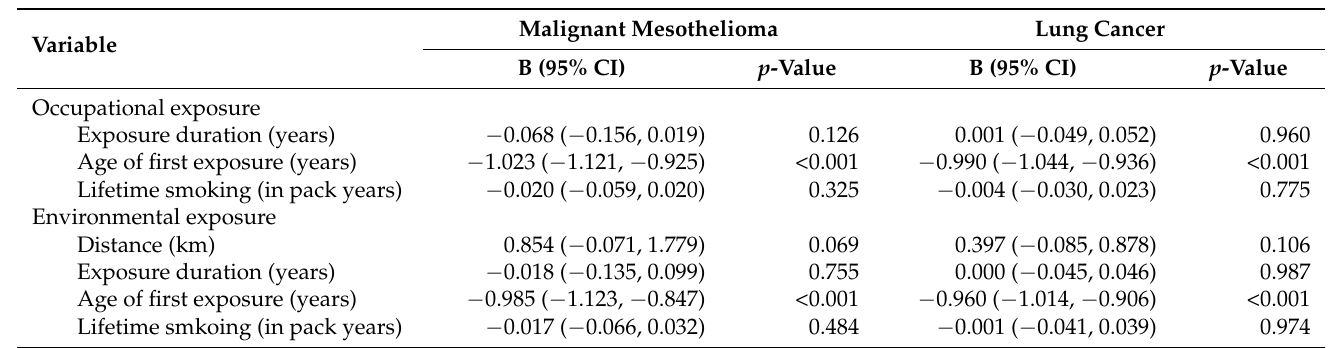
Table 4. Regression coefficients for mean latency periods by continuous exposure indicators after adjusting for